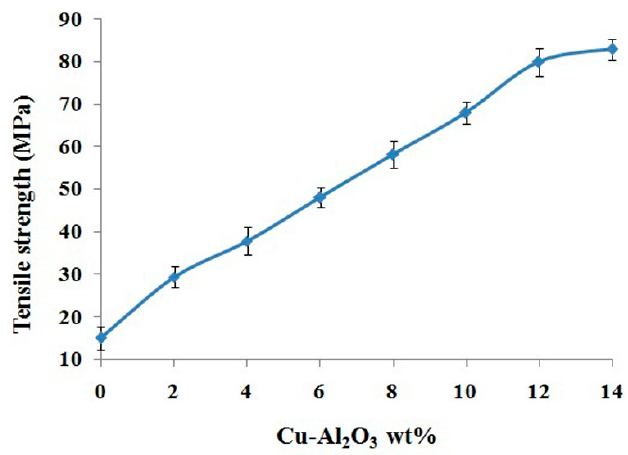
Figure 9. Tensile strength of Cu–Al 2 O 3 /PS- b -(PE- r -B)- b -PS- g -MA composites. Table 4. Comparison of the tensile strength of PS- b -(PE- r -B)- b -PS- g -MA/Cu-Al 2 O 3 composites with previously reported data.